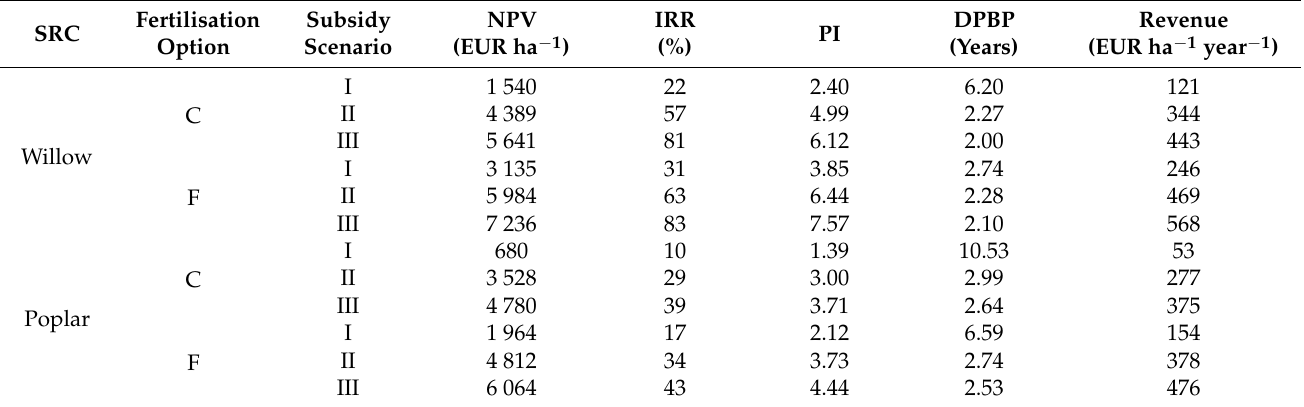
Table 3. Profitability indices for willow and poplar chip production depending on the soil fertilisation option and subsidy